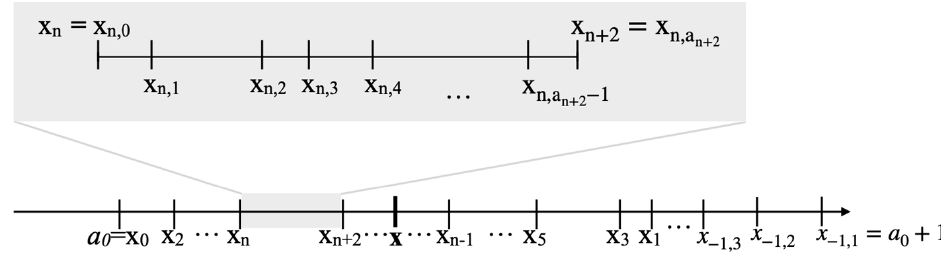
Figure 8. Nesting of convergents and semiconvergents (n even).